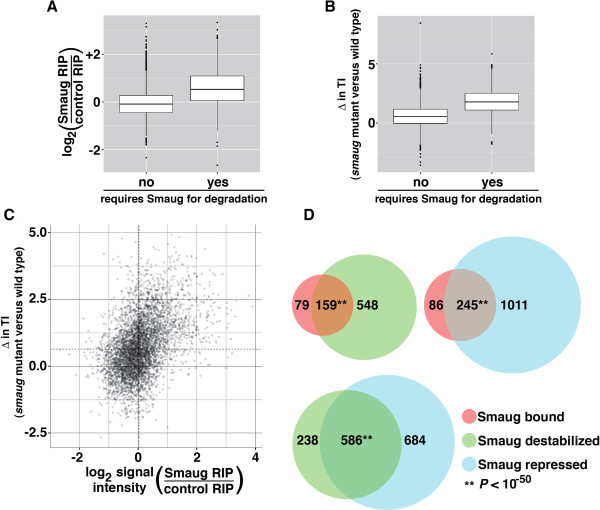
Comparisons of Smaug-bound, repressed and degraded data sets. (A) Smaug binding was assessed using the fold enrichment in Smaug RIPs compared to control RIPs and box plots were used to show the range of these enrichments for the targets of Smaug-mediated mRNA decay and for non-targets. (B) Smaug-mediated translational repression was assessed using the change in TI in smaug-mutant compared to wild type and box plots were used to show the range of these changes for the targets of Smaug-mediated mRNA decay and for non-targets. (C) Smaug binding and translational repression were quantified as described in (A) and (B), respectively, and these values were plotted against one another. The dashed vertical and horizontal lines represent the median values for Smaug binding and Smaug-mediated translational repression, respectively. (D) Venn diagrams to show the overlap between the genes whose mRNAs are bound by Smaug, those that are degraded by Smaug and those that are translationally repressed by Smaug (FDR <10%). Note that, for each comparison, only genes scored as ‘expressed’ in both data sets were included.